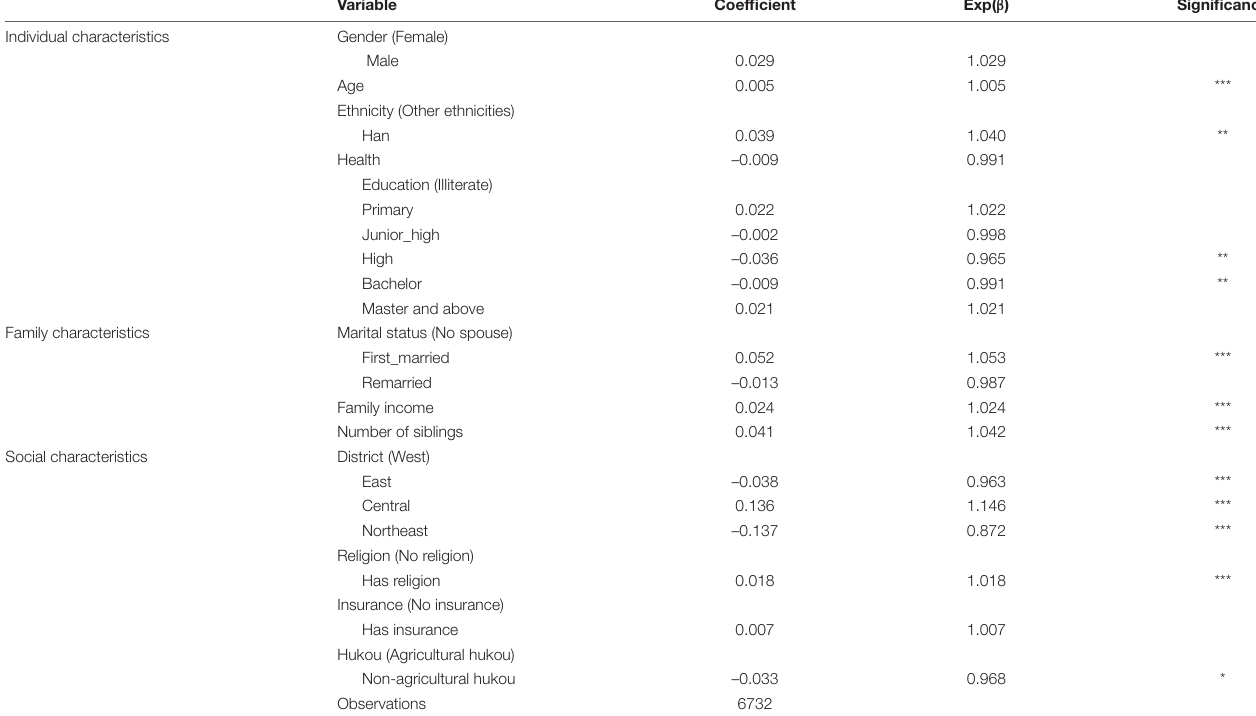
TABLE 8 | Logistic full-sample regression results.